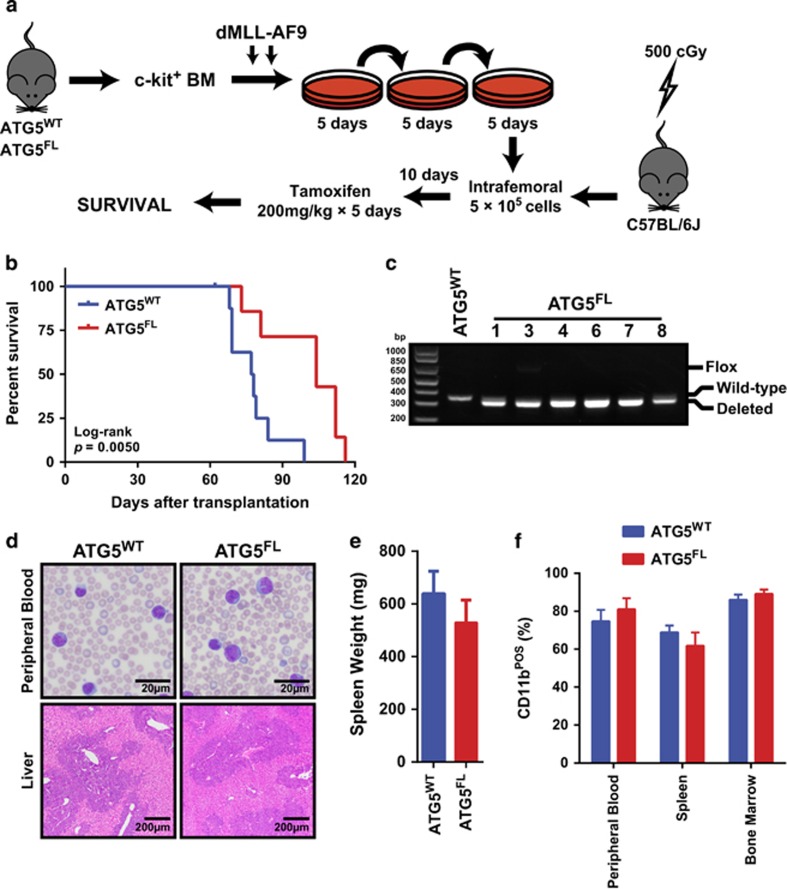
Development of AML in mice transplanted with ATG5WT and Atg5FL MLL-AF9-BM cells transduced with dMLL-AF9 and treated with tamoxifen. (a) A schematic representing the strategy by which the role of Atg5-dependent autophagy was assessed during primary transplantation in MLL-AF9-driven AML. (b) The Kaplan–Meier survival curve of mice transplanted with Atg5WT (n=8) and Atg5FL (n=7) MLL-AF9 cells. The P-value for the log-rank test between the two groups is shown. (c) Genomic DNA extracted from the splenocytes of a representative Atg5WT and six Atg5FL moribund mice from panel (b) were analyzed by PCR for the status of Atg5 alleles. (d) Representative figures of peripheral blood smears stained by May Grünwald–Giemsa (top) and liver section stained by hematoxylin and eosin (bottom) of moribund mice from panel (b). (e) The spleen weight of moribund mice from panel (b) for Atg5WT (n=7) and Atg5FL (n=6) mice. Error bars represent S.E.M. (f) The Annexin V−7-AAD−CD11b+ myeloid cells are shown as percentage of all Annexin V−7-AAD− cells according to flow cytometry in the indicated hematopoietic tissues of moribund mice from panel (b). Error bars represent S.E.M. of six mice